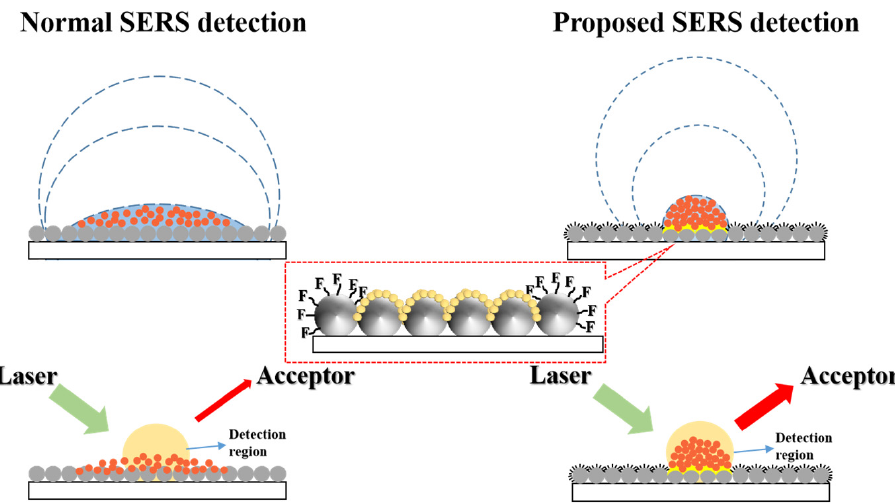
Figure 1. Schematic of normal SERS detection ( Left ) and proposed SERS detection ( Right ). For normal SERS detection, the droplet spreads over the substrate by capillarity and then continuously and completely evaporates; the limited detection sensitivity could be attributed to the restricted detection region of instruments (e.g., spot size of laser) versus the sparse distribution of target analytes. In contrast, SERS substrate with HWS could highly concentrate analytes within the detection region due to high hydrodynamic-flow resistance and then increase the limit of detection. Inset (red dashed box) showed HWS acquired by sputtering Au NPs (hydrophilic) and modifying—F groups (hydrophobic), respectively.